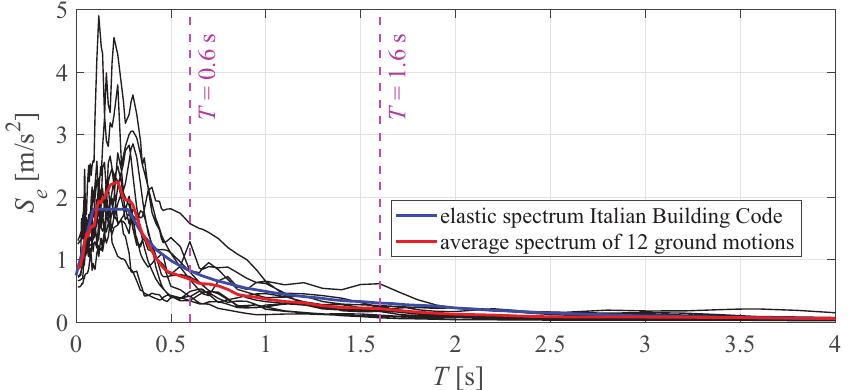
Figure 5. Elastic acceleration spectra of the 12 records (black lines) listed in Table 2, their average (red line), and elastic spectrum (blue line) specified by the Italian Building Code [34] for a return period of T R = 35 years and soil type